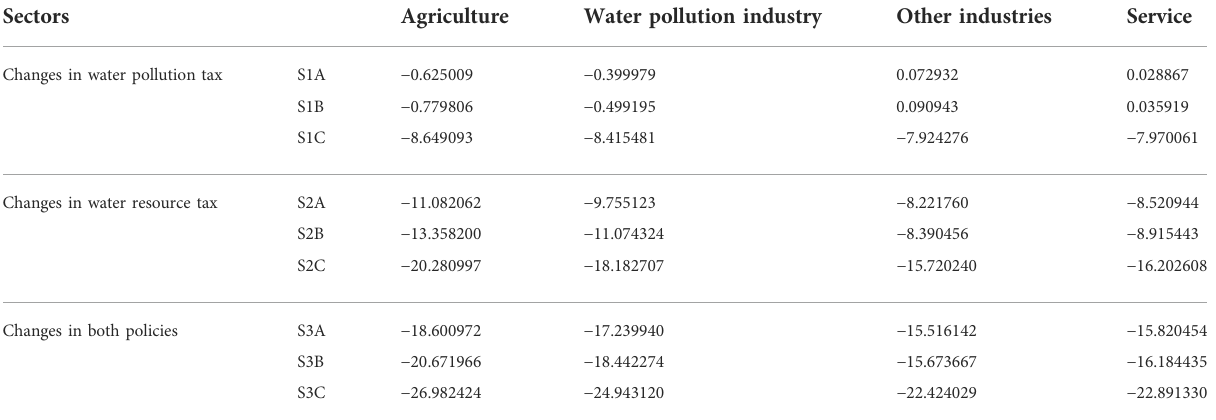
TABLE 4 Water pollutant variation of each industry under different scenarios (%). Sectors